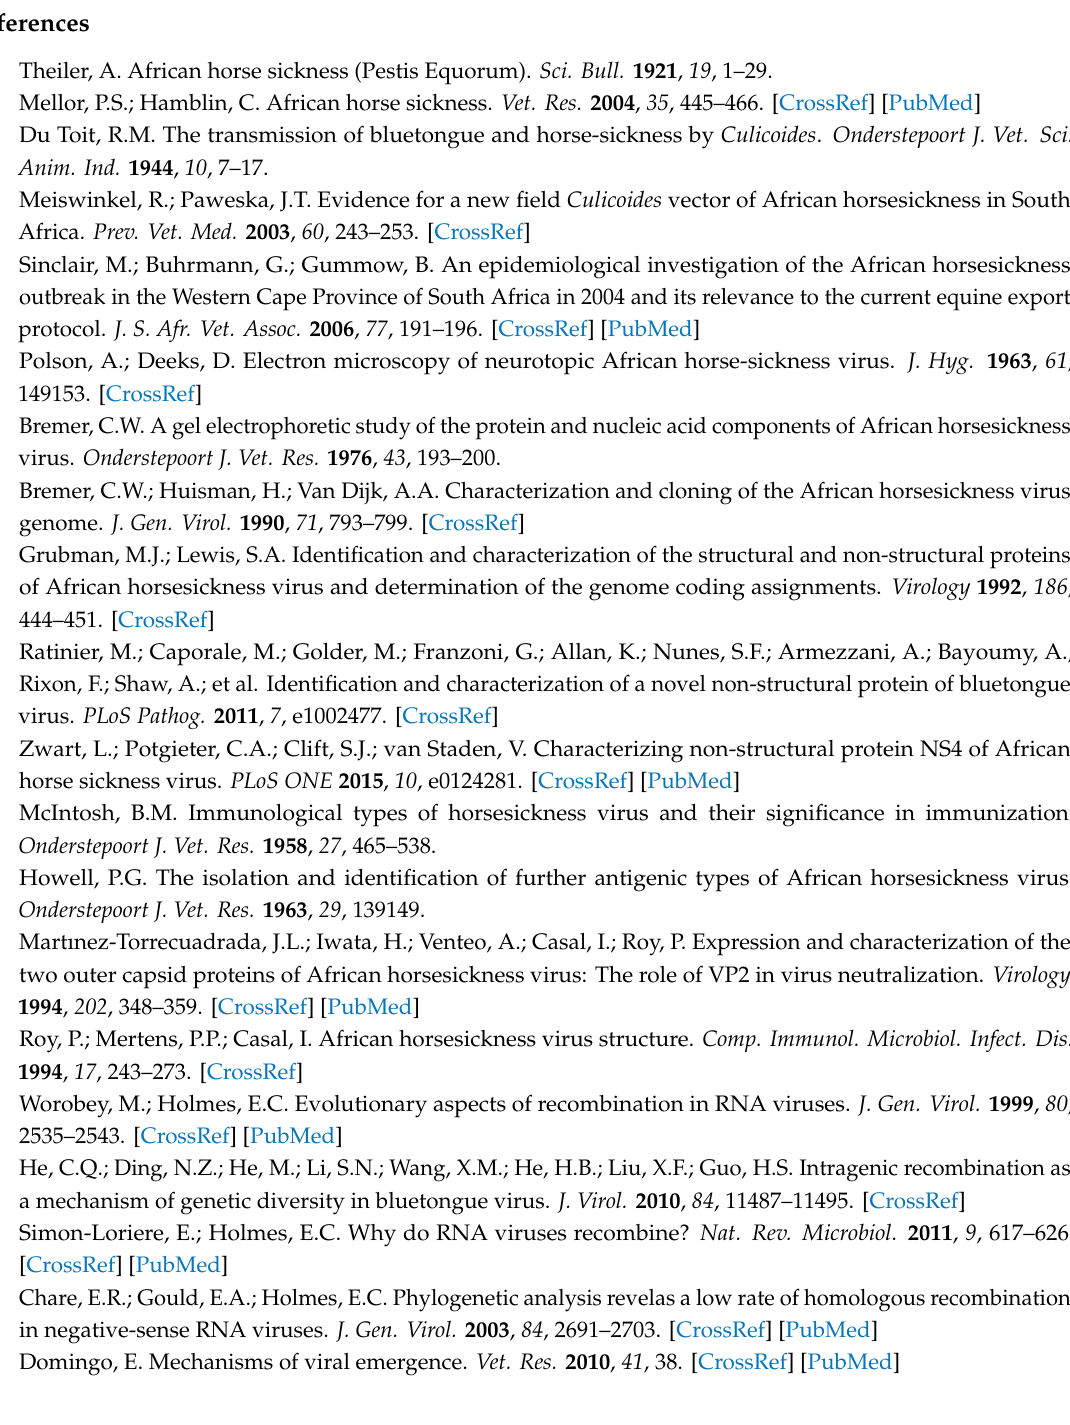
Table S1: Origin, isolate name and passage history of AHSV isolates used for the sequence analyses used in this